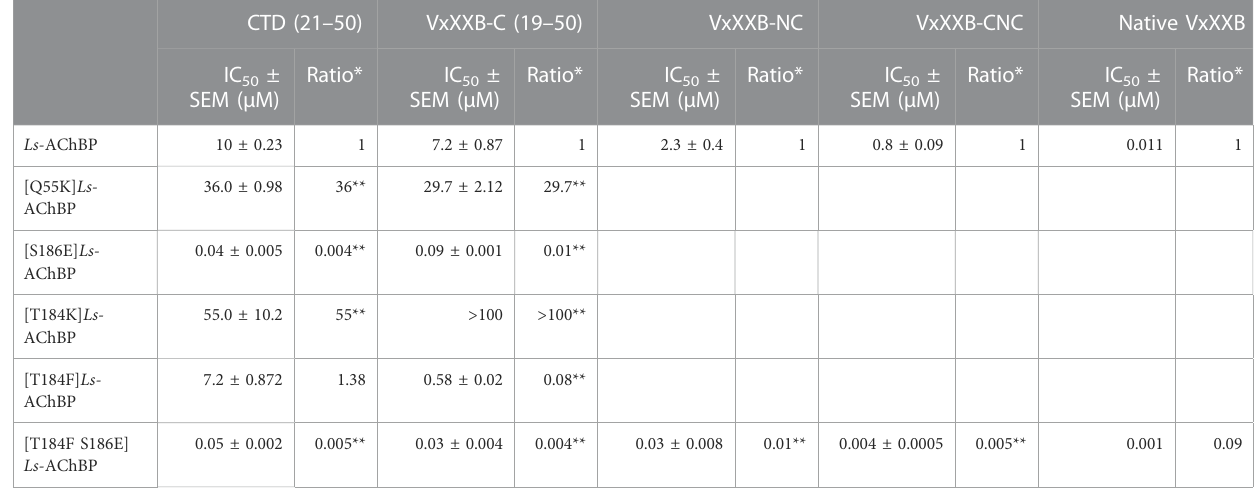
TABLE 1 IC 50 values for displacement of [ 3 H]-epibatidine binding to Ls -AChBPs and mutant Ls -AChBPs by CTD (19 – 50), VxXXB-C (21 – 50), VxXXB-NC and